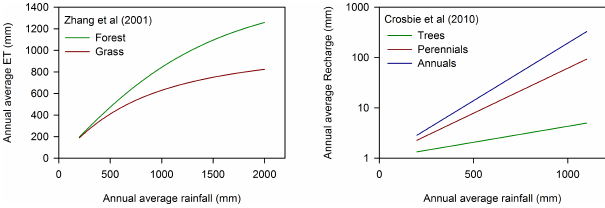
Fig. 8. Comparison of the evapotranspiration and recharge for dif- ferent vegetation derived from observed field data. The evapotran- spiration curves are derived from Fig. 9 in Zhang et al. (2001) and the recharge curves are derived from Fig. 6 in Crosbie et al.